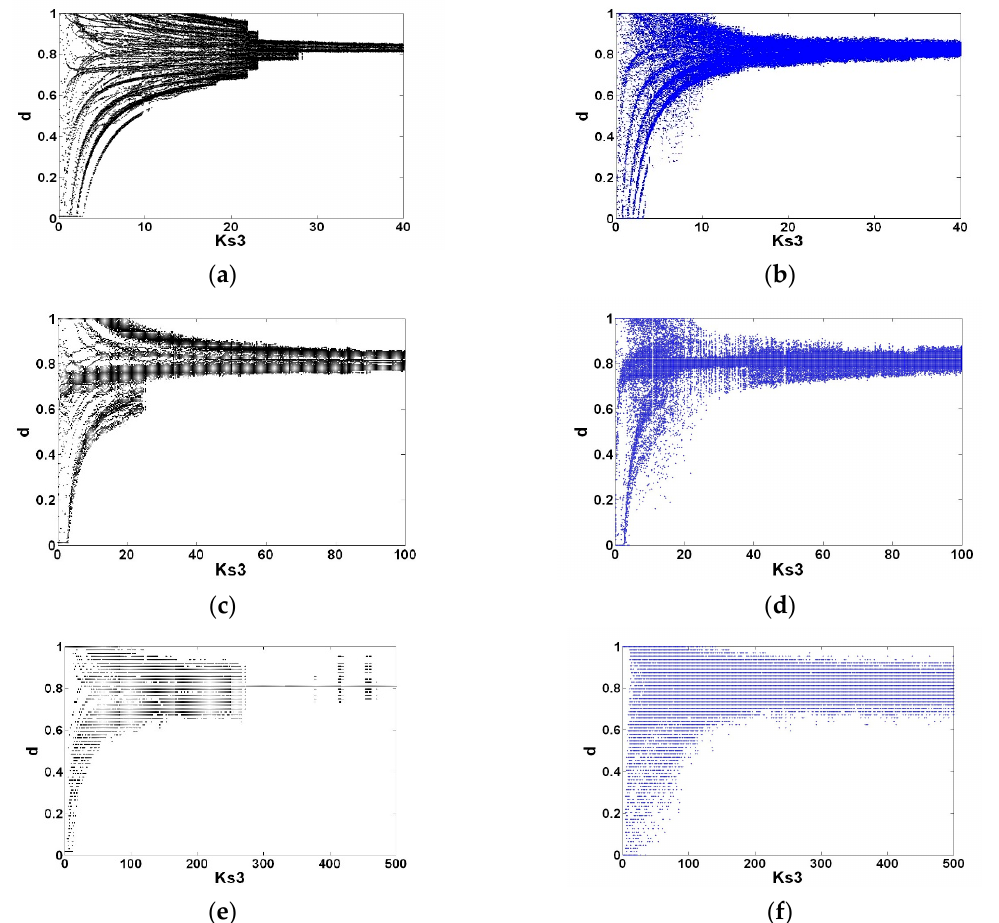
Figure 4. Numerical and experimental bifurcation diagrams for the duty cycle d with respect to the control parameter K S 3 . These diagrams are plotted considering the following quantization levels: ( a ) W m with 28 bits, analog–digital (ADC) inputs with 12 bits, d with 10 bits; ( b ) W m with 28 bits, ADC with 12 bits, and d with 10 bits; ( c ) W m with 26 bits, ADC with 10 bits, and d with 8 bits; ( d ) W m with 26 bits, ADC with 10 bits, and d with 8 bits; ( e ) W m with 24 bits, ADC with 8 bits, and d with 6 bits; and ( f ) W m with 24 bits, ADC with 8 bits, and d with 6